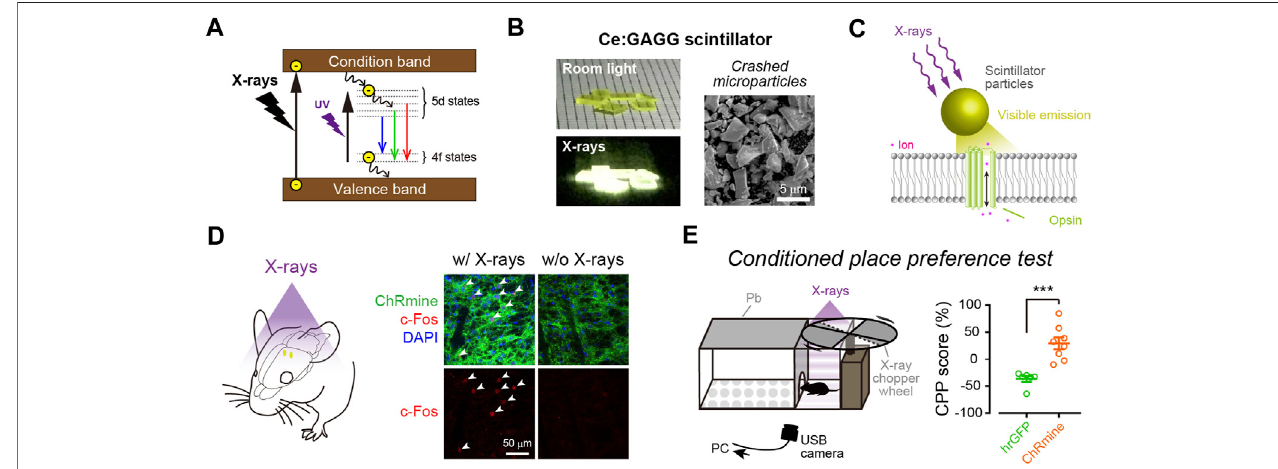
FIGURE 2 | X-ray-mediated optogenetics using scintillator microparticles. (A) Schematic of the energy level diagrams of scintillation. (B) Left, images of Ce:GAGG crystals illuminated with room light (top) or X-rays (bottom). Right, a scanning electron micrograph image of Ce:GAGG microparticles. (C) Schematic of the technology. X-ray-inducedvisibleemissionsbyscintillatorparticlesactivateopsins. (D) ExpressionofcFos(red)isinducedinChRmine-expressingneurons(green)byX-ray-induced radio-luminescence emitted from Ce:GAGG microparticles in vivo at a depth of ∼ 4.2 mm (the schematic illustrated in left). (E) Conditioned place preference (CPP) can be induced by activating midbrain dopamine neurons with X-ray-mediated optogenetics (right), using a test chamber where X-ray pulses are irradiated in a compartment (left). (B – E) , images modi fi ed with permission from Matsubara et al. (2021).